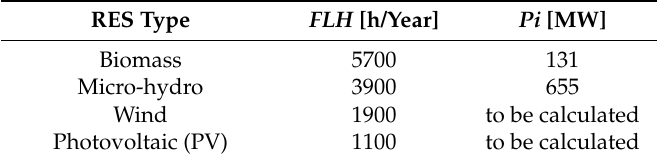
1100 to be calculated